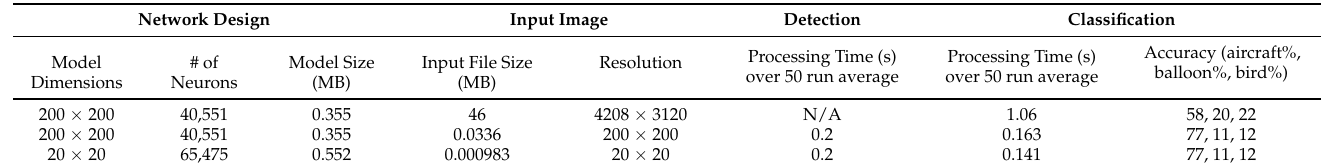
Table 3. Custom deep learning